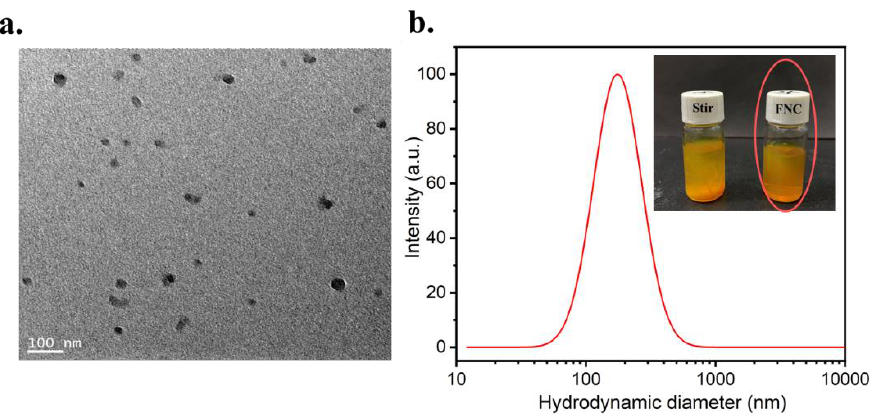
Figure 2. ( a ) TEM image of the Cur-loaded CS nanocomplex. ( b ) DLS profiles with pictures of the samples shown in the inset.